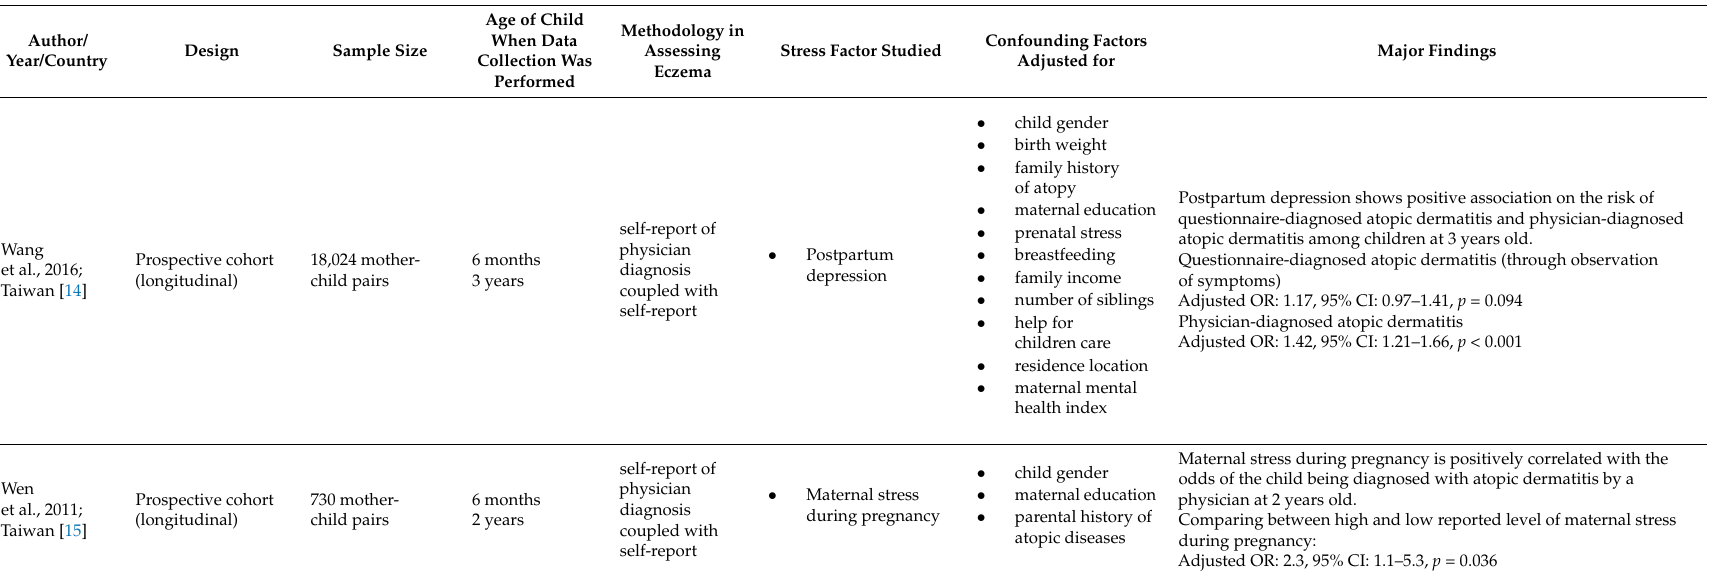
physician at 2 years old. Comparing between high and low reported level of maternal